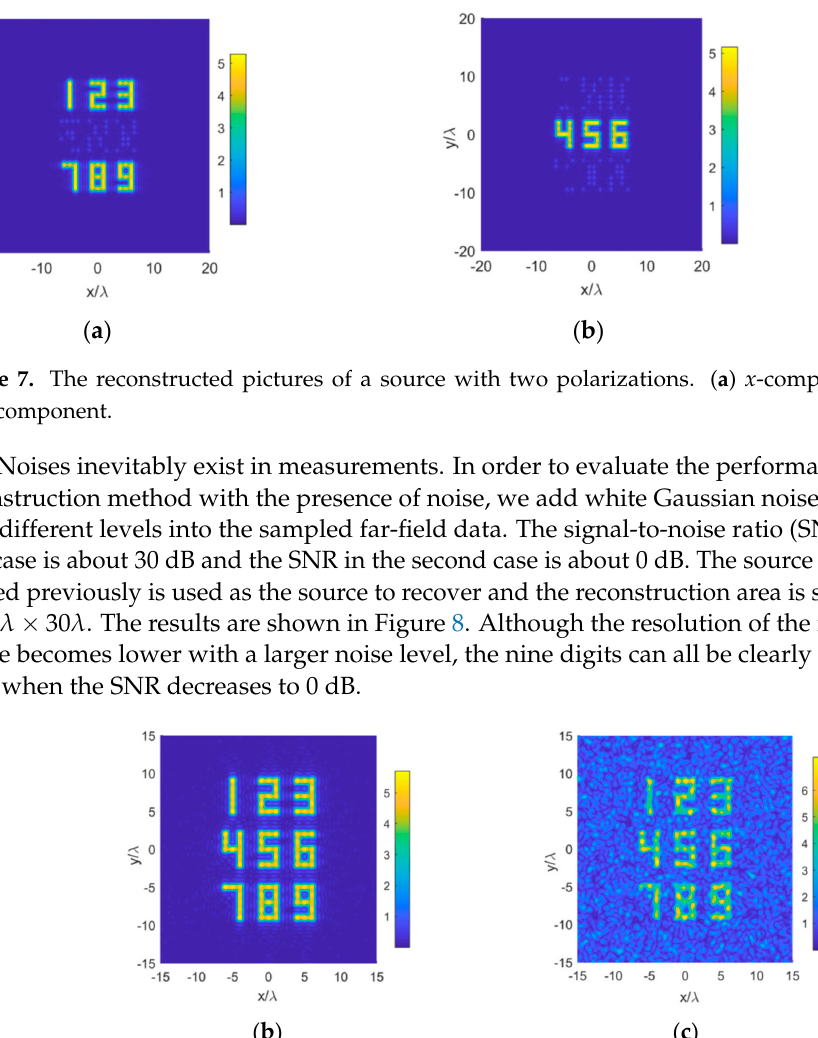
( d ) Figure 6. The reconstructed currents when the source area rotates with an angle of ( a ) 45 ° and ( b ) 80 ° , and shifts by 20 λ in the ( c ) x -direction and ( d ) y -direction.